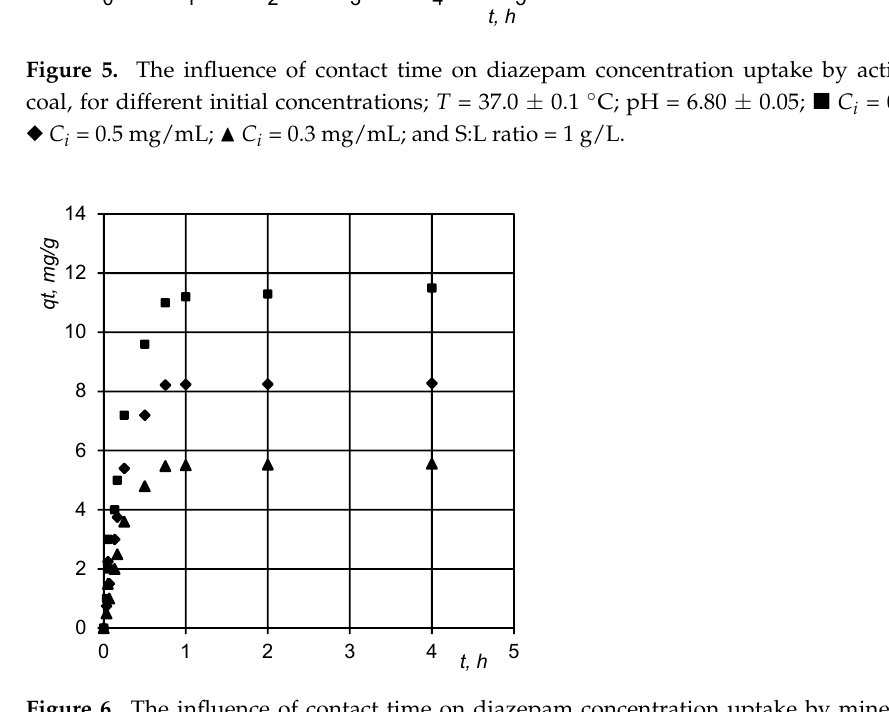
Figure 7. The influence of contact time on diazepam concentration uptake by activated charcoal for different sorbent particle sizes; T = 37.0 ± 0.1 °C; pH = 6.80 ± 0.05; C i = 0.7 mg/mL; ■ D < 10 μ m; ◆ 10 μ m < D < 15 μ m; ▲ 15 μ m < D < 18 μ m; and S:L ratio = 1 g/L.